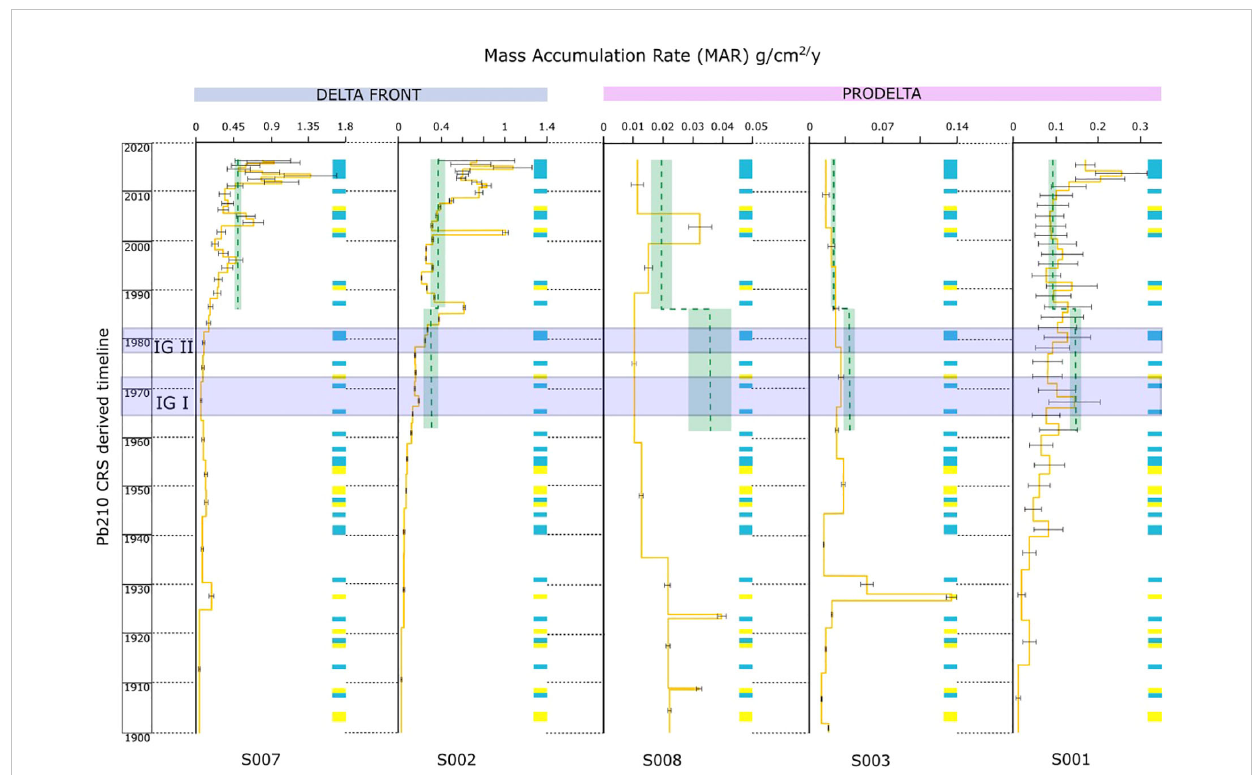
FIGURE 7 Mass accumulation rates in g/cm 2 /y for the Danube delta front and the prodelta, based on the time line obtained from 210 Pb dating (orange line), using the CRS (Constant Rate of Supply) model and 137 Cs (green line). The input of dams on the time line (Iron Gate I – 1964-1972 and Iron Gate II – 1978-1982) is marked by the purple square. The blue and yellow squares mark major fl oods (1907, 1914, 1919, 1924, 1932, 1940-1941, 1944, 1947, 1954-1956, 1958, 1962, 1965, 1970, 1975, 1980-1981, 1988, 1991, 2002, 2005-2006, 2010, 2013-2014) and hydrological droughts (1902, 1904,